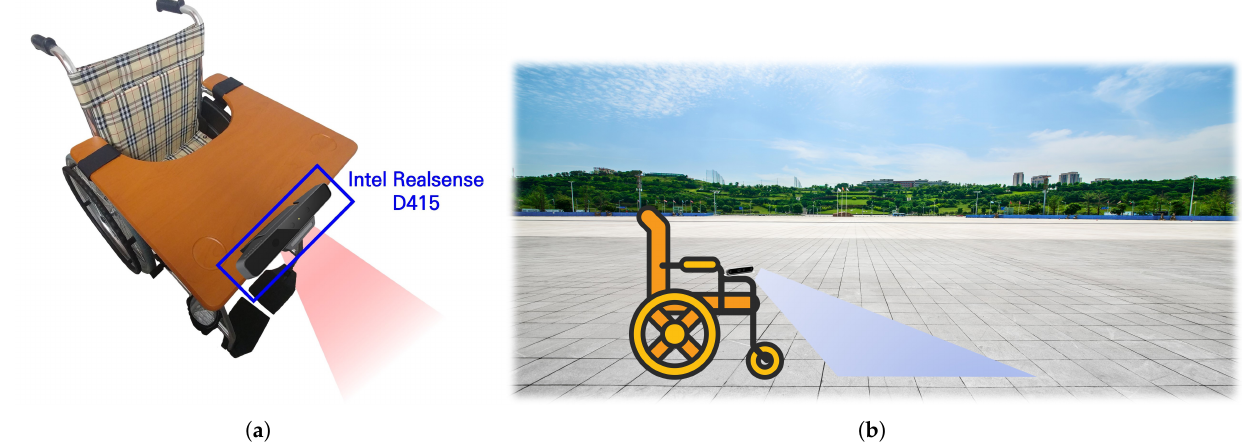
Figure 1. Wheelchair setup. ( a ) Hardware setup, ( b ) Recording